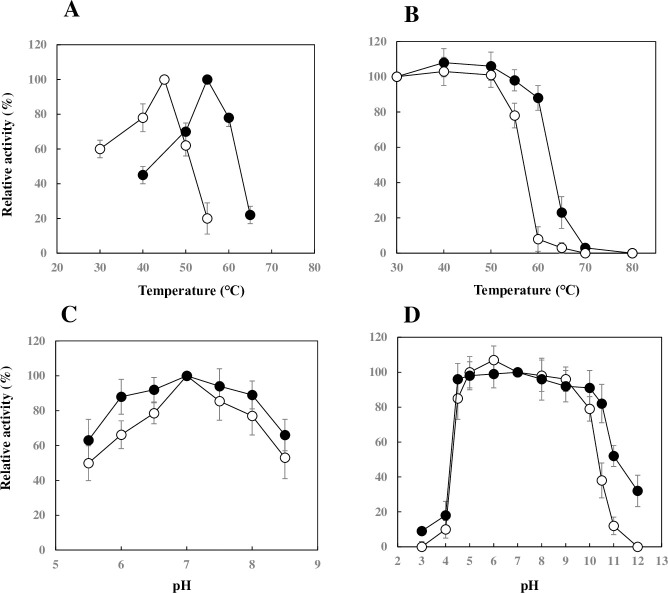
Effects of pH and temperature on the activity and stability of cholesterol oxidases.Effects of pH and temperature on the activity and stability of ChoRI (open circles) and ChoRII (closed circles) were measured. (A) Enzyme activity was determined by monitoring the A249 based on the λmax value of product formation at pH 7.0. (B) Thermal stability (closed circles) was assayed after incubation of the enzyme (0.2 U/ml) dissolved in 100 mM phosphate buffer (pH 7.0) for 30 min at the temperatures indicated, and the relative activity was examined by measuring H2O2 generation at 30°C. (C) Enzyme activity was assayed by following the consumption of oxygen at 30°C. (D) The pH stability was determined after incubation at 30°C for 1 h under the pH conditions indicated. The residual activity was examined by measuring H2O2 generation at 30°C. The buffer systems (100 mM) were glycine-HCl (pH 3.0), citrate-sodium citrate (pH 3.0–4.0), CH3COOH-CH3COONa (pH 5.0–5.5), NaH2PO4-Na2HPO4 (pH 5.5–7.5), Tris-HCl (pH 7.5–9.0), Na2CO3-NaHCO3 (pH 9.0–11.0), and NaCl-NaOH (pH 11.0–12.0). Data are the means of experiments performed in triplicate. Error bars represent the standard deviation.